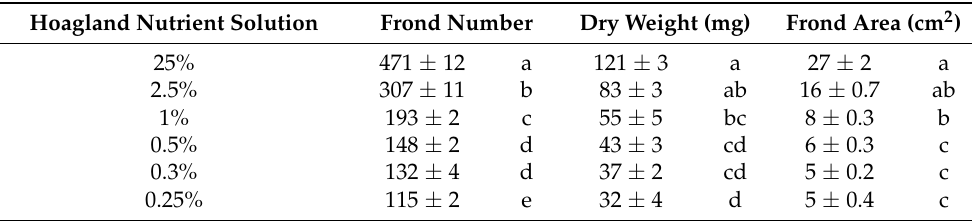
Table 3. Mean ± standard error for Experiment 1 dry weight, frond number, and frond area of Lemna minor after 14 days in different Hoagland solutions.